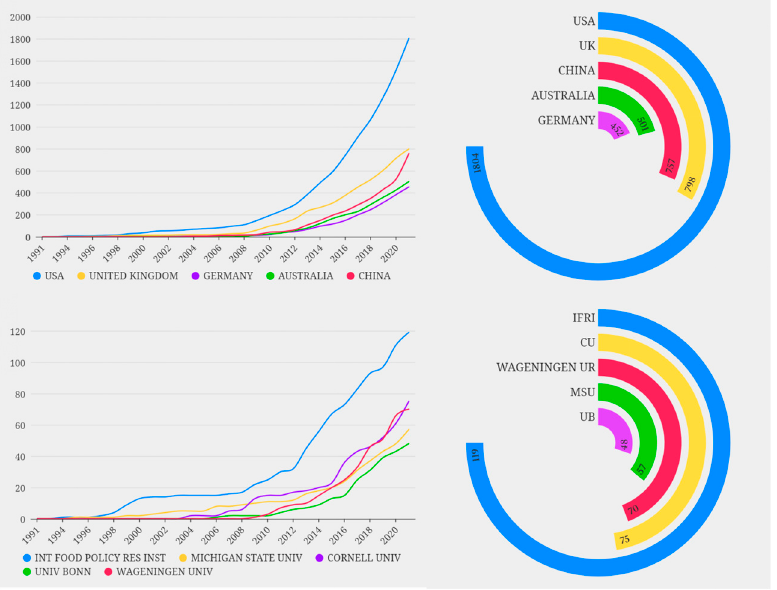
Figure 5. Top 10 countries and institutions publishing in the field of food security. Note: